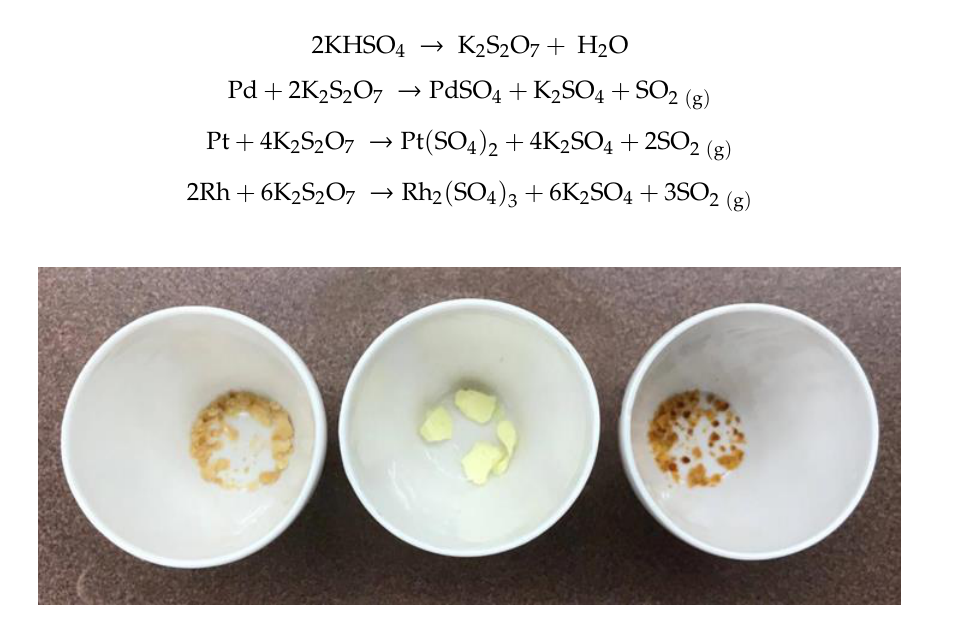
Table 1. Chemical composition of PGE in used catalytic converters. Elements